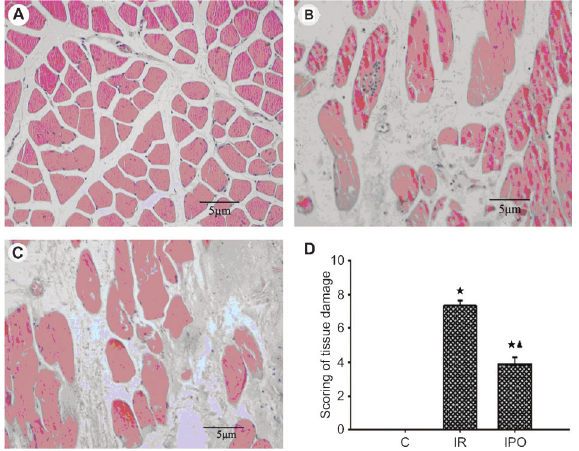
Figure 2. Histological evaluations of skeletal muscle tissue. Representative skeletal muscle sections were obtained 3 h after sham surgery or ischemia-reperfusion (IR). A , Section from sham-operated group. B , Section from IR group. C , Section from ischemic postconditioning (IPO) group. All of the sections were stained with hematoxylin and eosin. Scale bar=5 m m. Skeletal muscle IR resulted in significant injury as demonstrated by skeletal muscle cells edema, sarcoplasm dissolution and necrosis, interstitial vessel hyperemia and hemorrhage, and neutrophil infiltration. However, IPO treatment ameliorated severe skeletal muscle damage. Note that there were significant differences in the changes of histological properties between sham-operated, IR, and IPO groups. D , Roach DM score for acute skeletal muscle lesions from sham-operated control (C), IR, and IPO groups (n=36). Data are reported as means±SD. w P , 0.01 vs sham-operated group; m P , 0.01 vs IR group (one- way